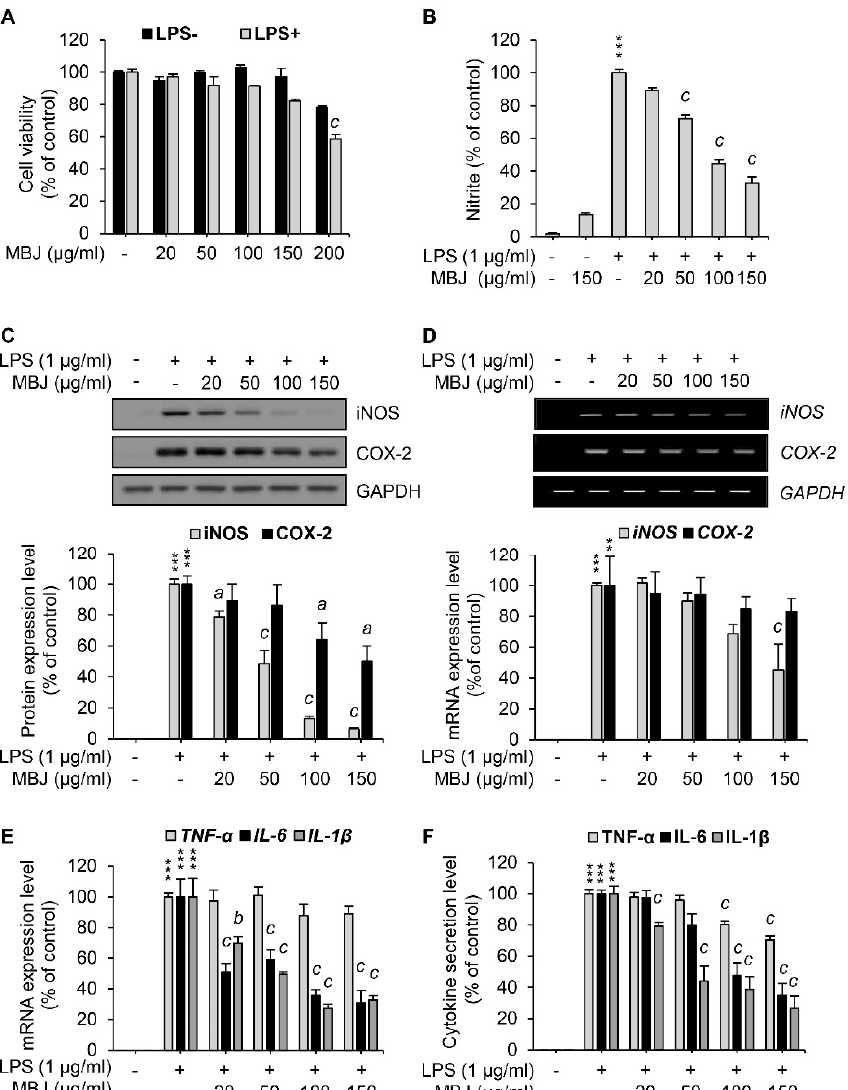
Figure 1. Inhibitory effects of MBJ on NO production, inflammatory gene expression, and cytokine secretion in RAW 264.7 macrophages. ( A ) RAW 264.7 macrophages were pre-treated with MBJ and then treated with or without LPS (1 µg/mL). The cell viability of each group was normalized to that of the MBJ-untreated group. The data represent the mean ± SEM; c p < 0.001 vs. the MBJ-untreated control group. ( B ) RAW 264.7 macrophages were pre-treated with MBJ and then stimulated with LPS (1 µ g/mL) for 24 h. The NO secretion level of each group was measured relative to the LPS- only treated group. The amounts of secreted NO were calculated according to a standard curve developed from a standardized nitrite solution. The data represent the mean ± SEM; *** p < 0.001 vs. the non-treated group; c p < 0.001 vs. the LPS-treated and MBJ-untreated control group. RAW 264.7 macrophages were pre-treated with MBJ for 2 h and then stimulated with LPS for 24 h ( C , F ) or 3 h ( D , E ). ( C ) The protein levels of iNOS and COX-2 were analyzed by immunoblotting analysis.